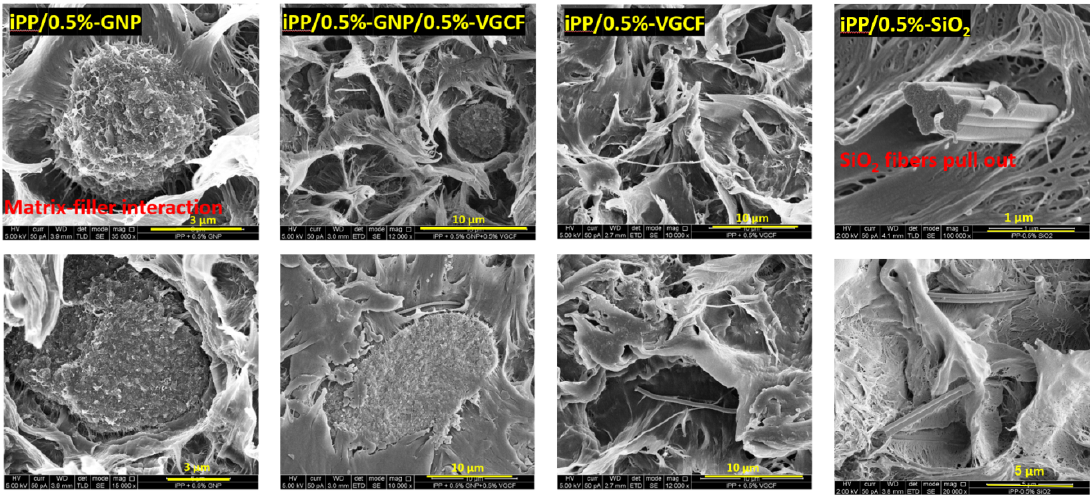
Figure 8. SEM images of nanocomposite cross-sections after mode I tensile. From left to right: iPP/0.5%-GNP, iPP/0.5%-GNP/0.5%-VGCF, iPP/0.5%-VGCF, and iPP/0.5%-SiO 2 .